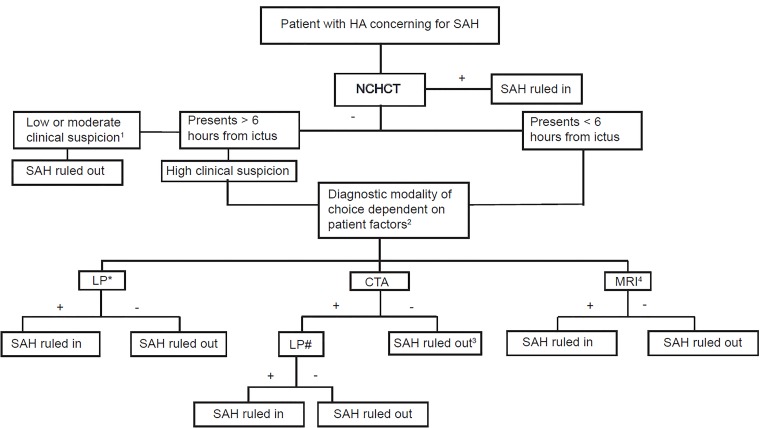
Algorithmic assessment for SAH in patient with sudden onset severe headache.HA, headache; SAH, subarachnoid hemorrhage; NCHCT, non-contrast head computed tomagraphy; LP, lumbar puncture; CTA, computed tomography angiography; MRI, magnetic resonance imaging.1With criteria met for Perry study [Perry et al. BMJ 2011]472Patient factors include anticoagulation status, patient willingness to undergo LP, history of lumbar spinal fusion or other surgery, and time from ictus (with longer time favoring MRI)3Caveat for this strategy includes the potential to miss aneurysms < 4 millimeters4MRI is an acceptable diagnostic at > 24 hours from ictus, prior to this sensitivity is lacking.*This is the recommended strategy by AHA/ASA, ACEP, and these authors#Recommended to decrease the false positive rate of CTA.